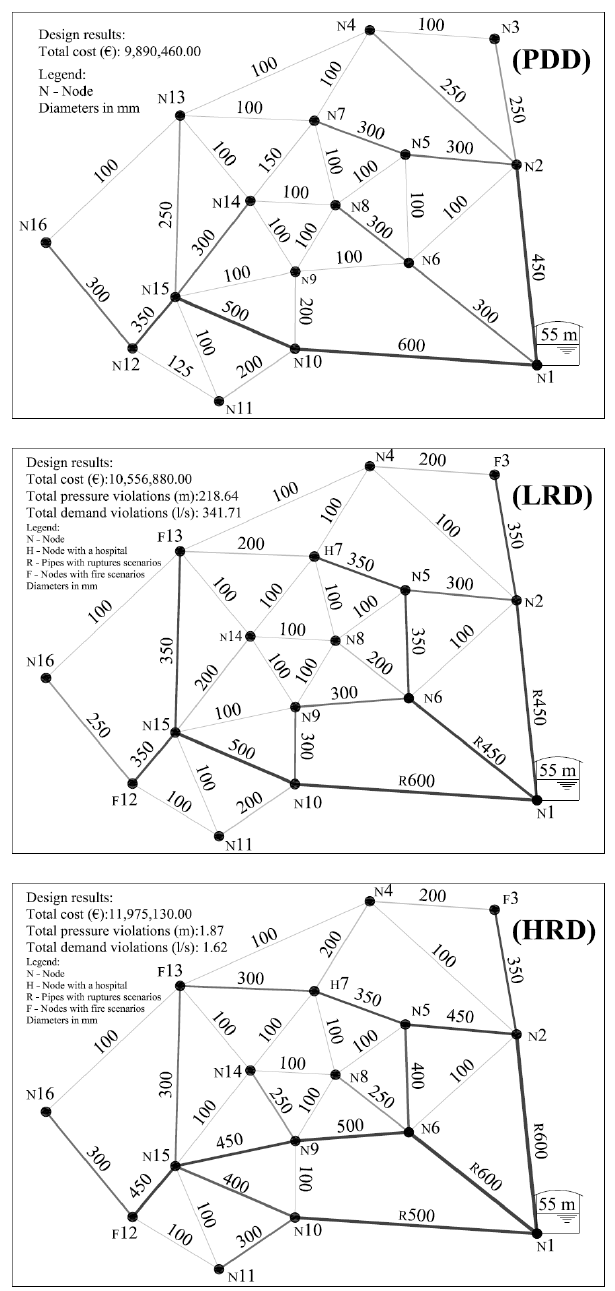
Figure 2. Designs for case study 1: (PDD) peak discharge (LRD) low robustness and (HRD) high robustness.